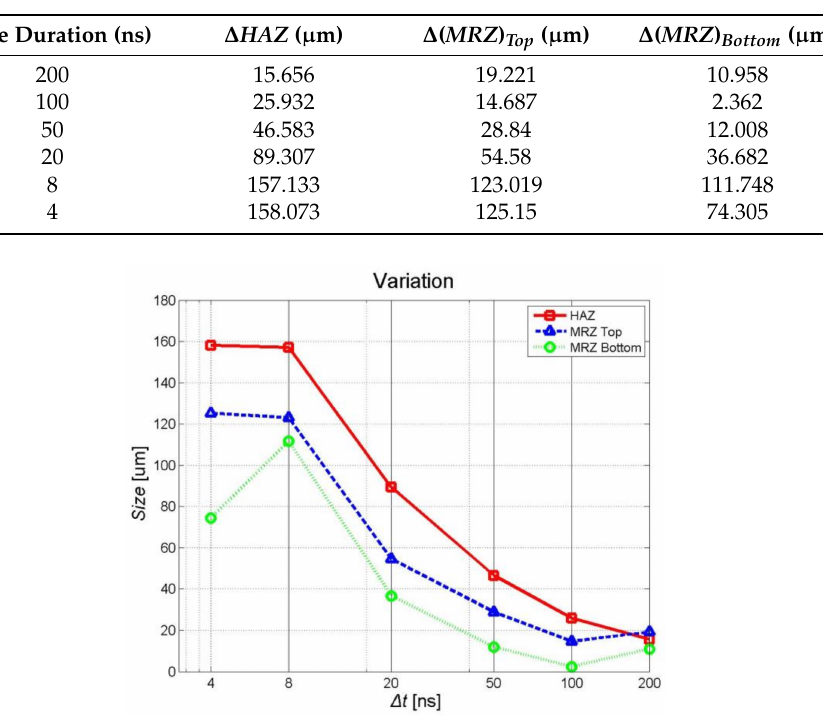
Figure 7. Comparison of ∆ HAZ , ∆ MRZ Top , and ∆ MRZ Bottom with the pulse duration from 4 ns to 200 ns. These values tend to increase as the pulse duration decreases. This can be explained by heat accumulation and material removal mechanism with effect of laser repetition rate and pulse